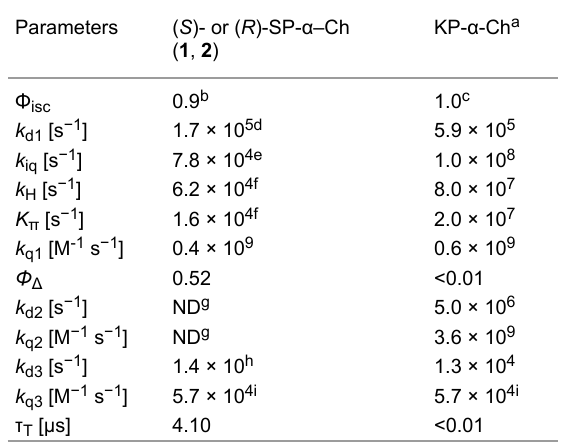
Table 1: Photophysical parameters of dyads in CH 2 Cl 2 .